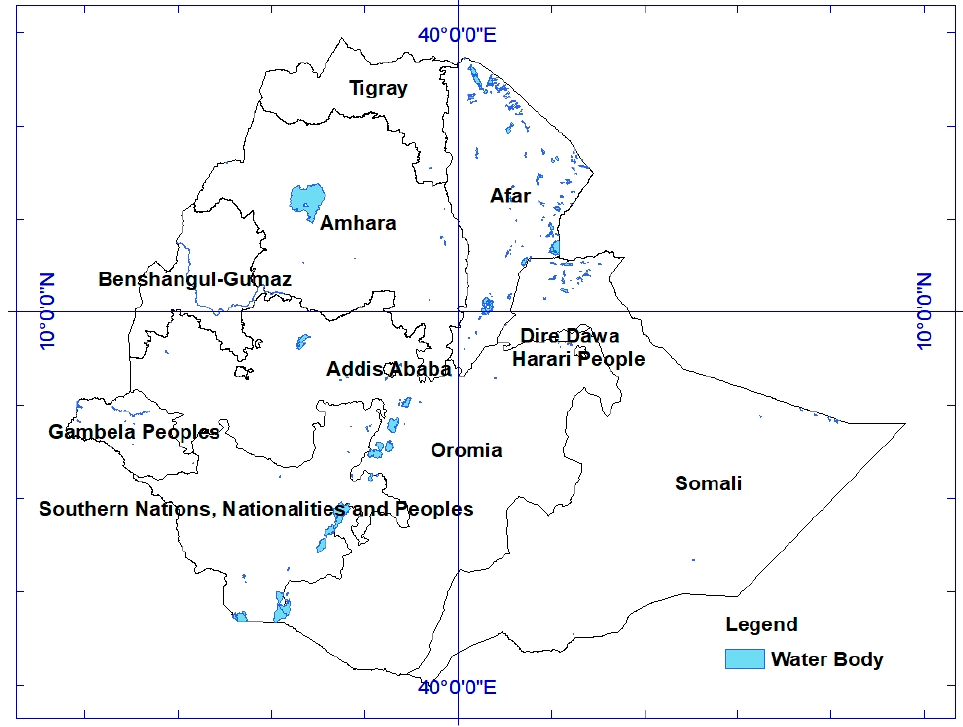
Figure 1. Ethiopia and its administrative regions with water bodies.